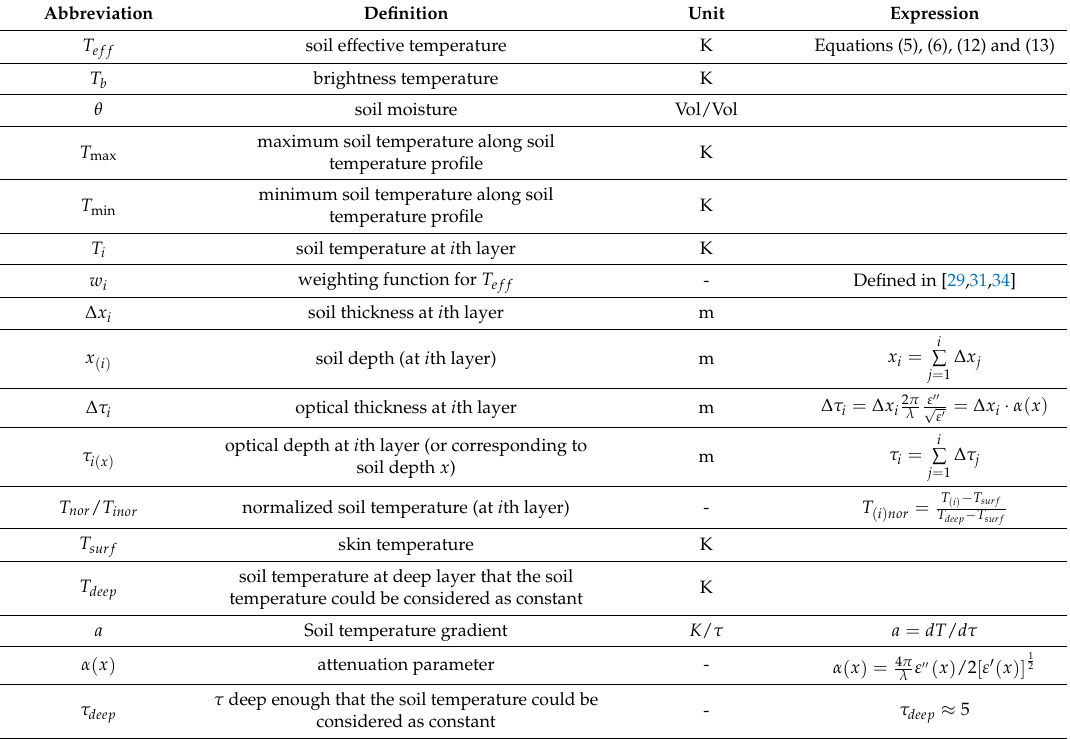
Table 1. Variables used in this